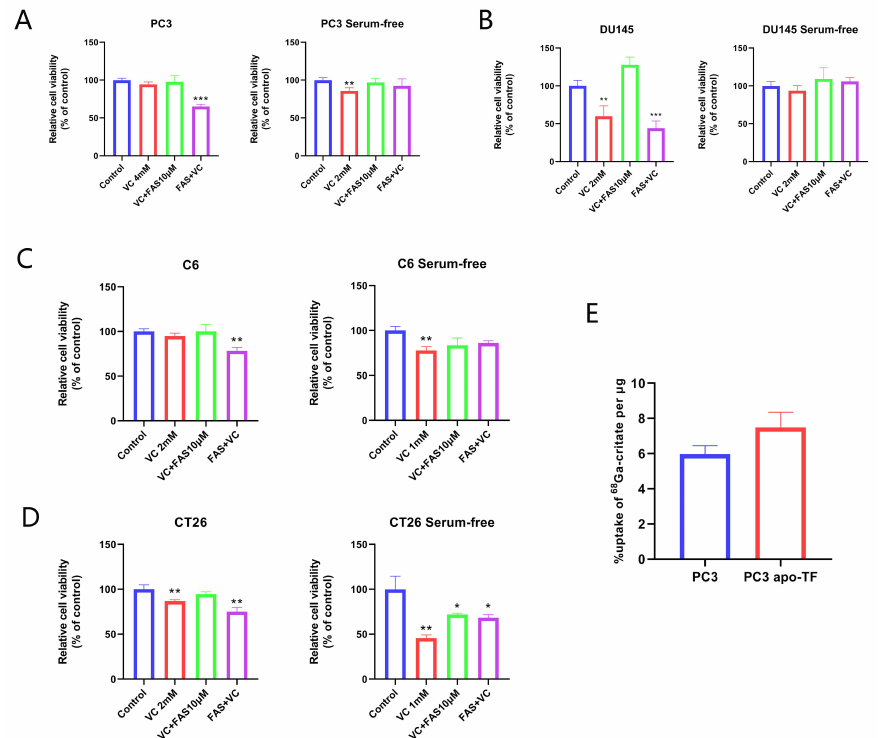
Figure 4. The effect of iron supplementation to VC-induced cytotoxicity is associated with TF. ( A – D ) Relative cell viability of four cell lines (PC3, DU145, C6 and CT26) after being pre-treated with 10 µ M FAS for 3 h, washed with PBS and then treated with different doses of VC for 3 h (iron supplementation intracellular) or co-exposure to 10 µ M FAS and different doses of VC for 3 h (iron supplementation extracellular). ( E ) The 68 Ga-citrate uptake rate of PC3 cells with and without apo-TF for 1 h. * p < 0.05, ** p < 0.01, *** p < 0.001.